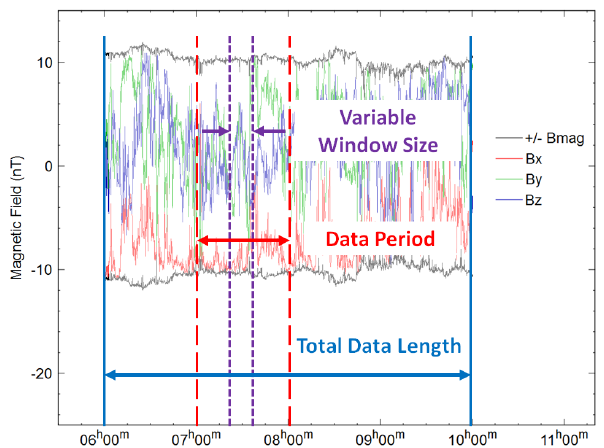
Fig. 1. An illustration of the time series nomenclature used in this paper. The total data length is the complete set of data within a sin- gle data file, shown here to be 4h. The data period is the dataset over which a final offset is calculated, shown here to be 1h. Conse- quently, this total data length would provide four offset calculations. The data period is repeatedly sub-divided into the variable window sizes from a length of 5min up to the maximum window size, which is equivalent to the data